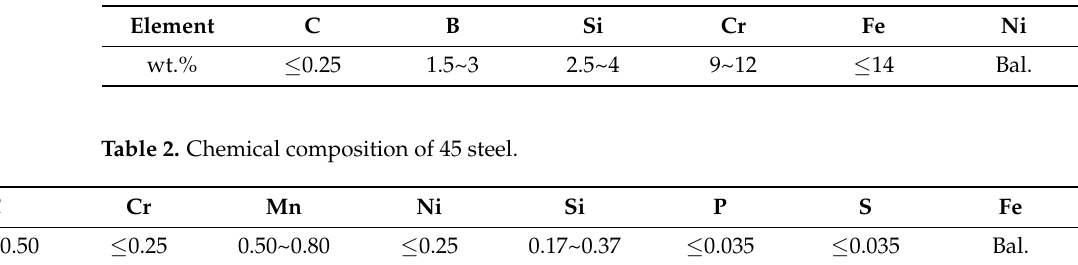
Table 1. Chemical composition of Ni35 powder.